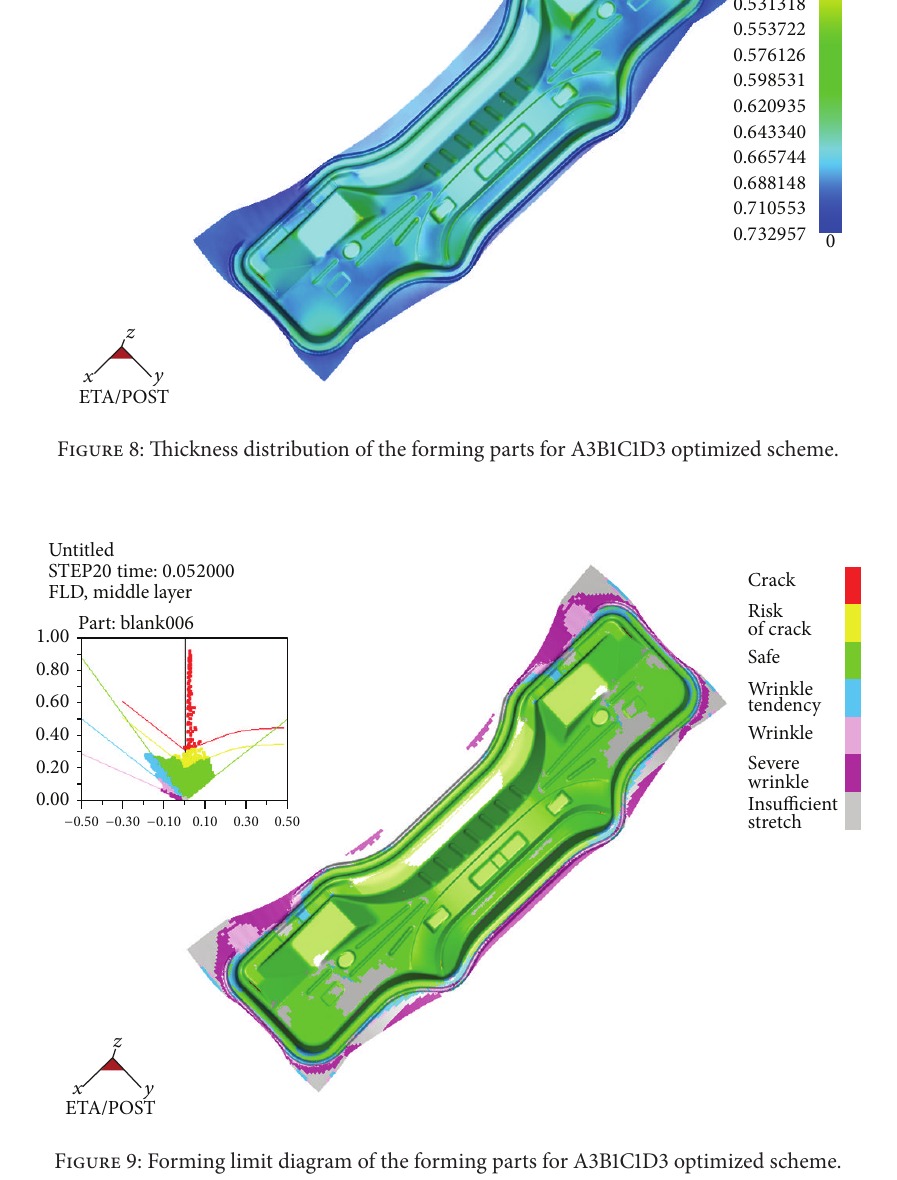
Figure 9: Forming limit diagram of the forming parts for A3B1C1D3 optimized scheme.